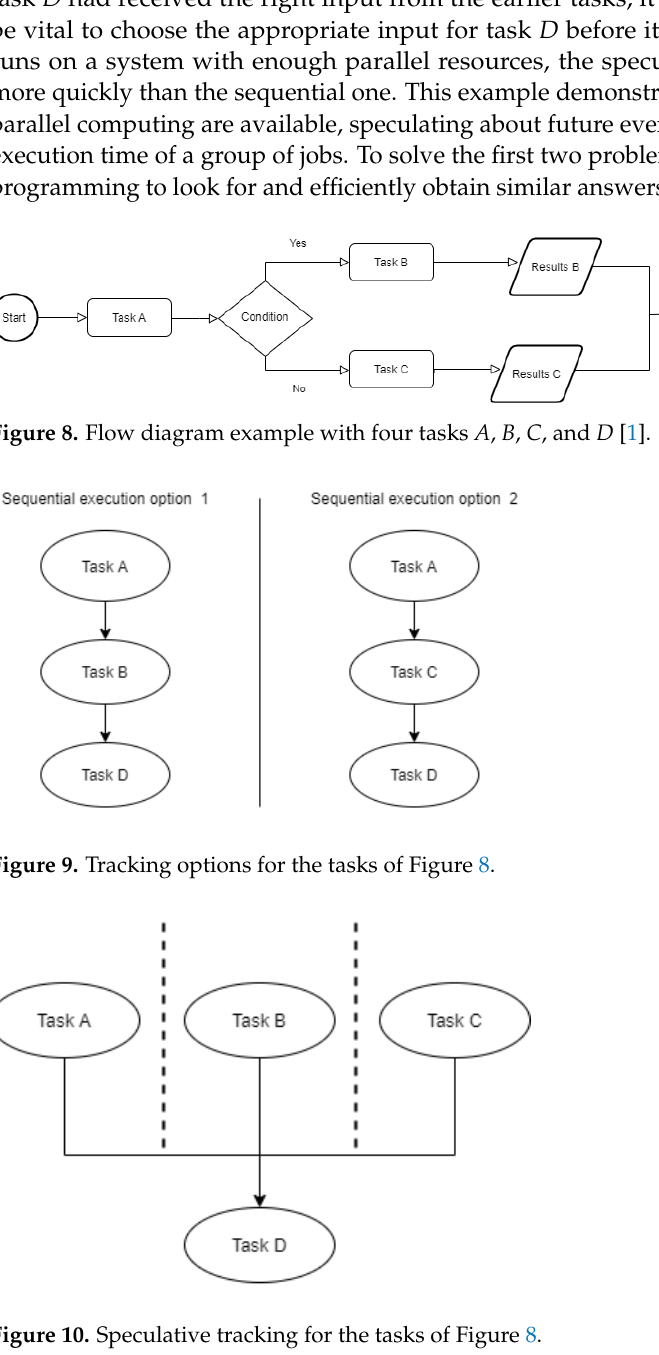
Figure 10. Speculative tracking for the tasks of Figure